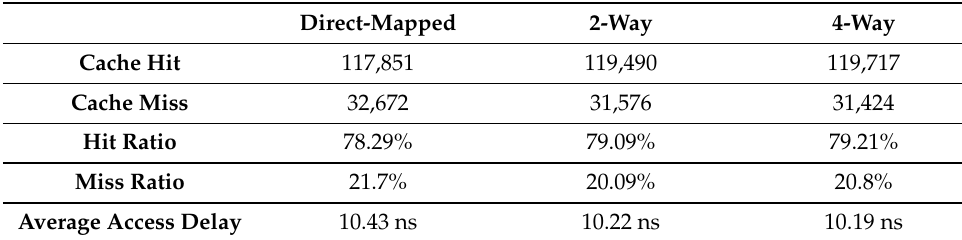
Table 4. Comparison of hit and miss rates of 10 K keys.